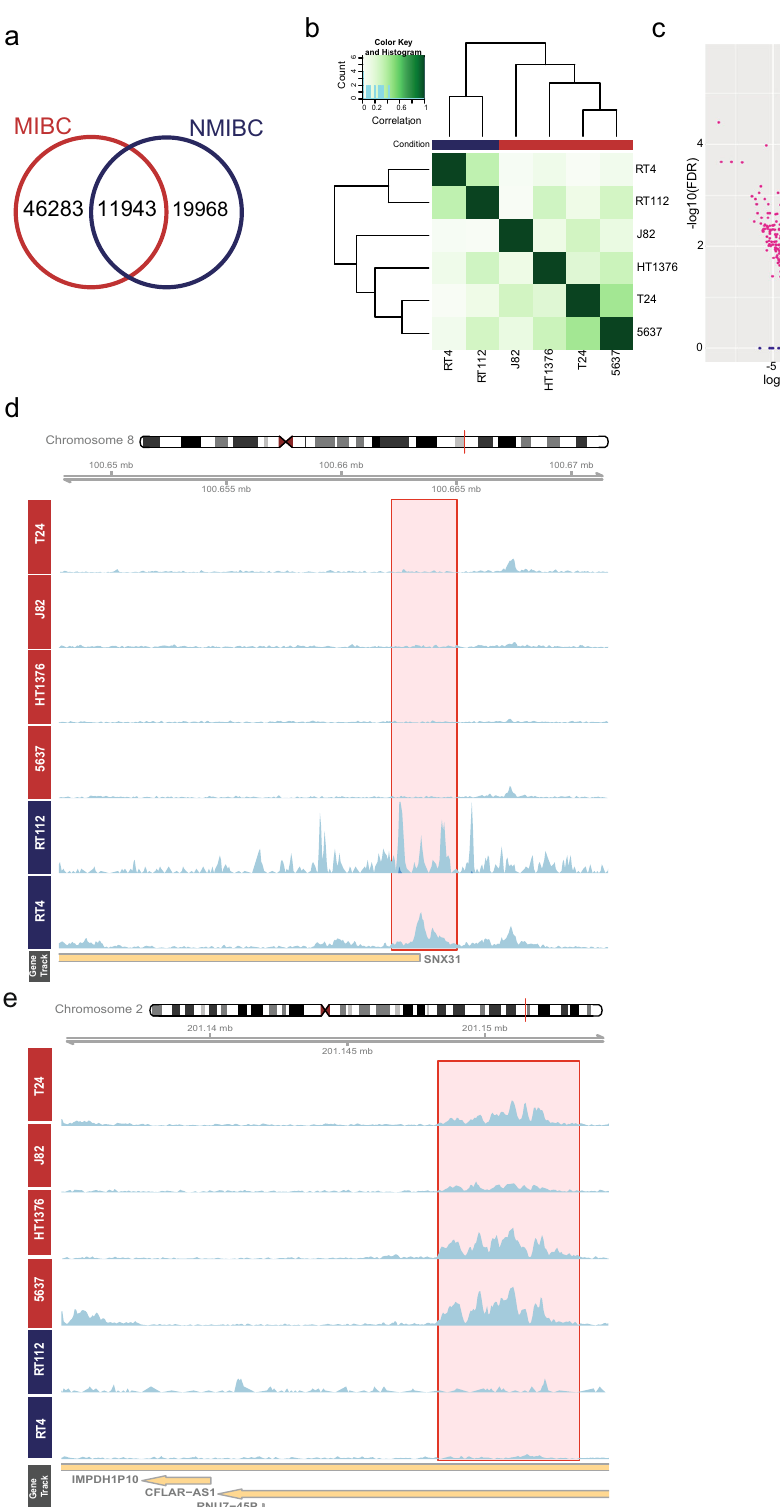
Fig. 1 Differentially regulated enhancers between NMIBC and MIBC cell lines. a Venn diagram showing the overlap between H3K27ac peaks called in NMIBC and MIBC. b Heatmap displaying the correlation among the cell lines according to the signals present at consensus H3K27ac peaks (unsupervised). c Volcano plot showing the differentially regulated enhancers (FDR = < 0.05) between MIBC and NMIBC ( n = 1699). d , e Snapshots visualize H3K27ac signal at exemplary NMIBC ( d ) and MIBC-( e ) speci fi c enhancers. Scale of the snapshots are adjusted to